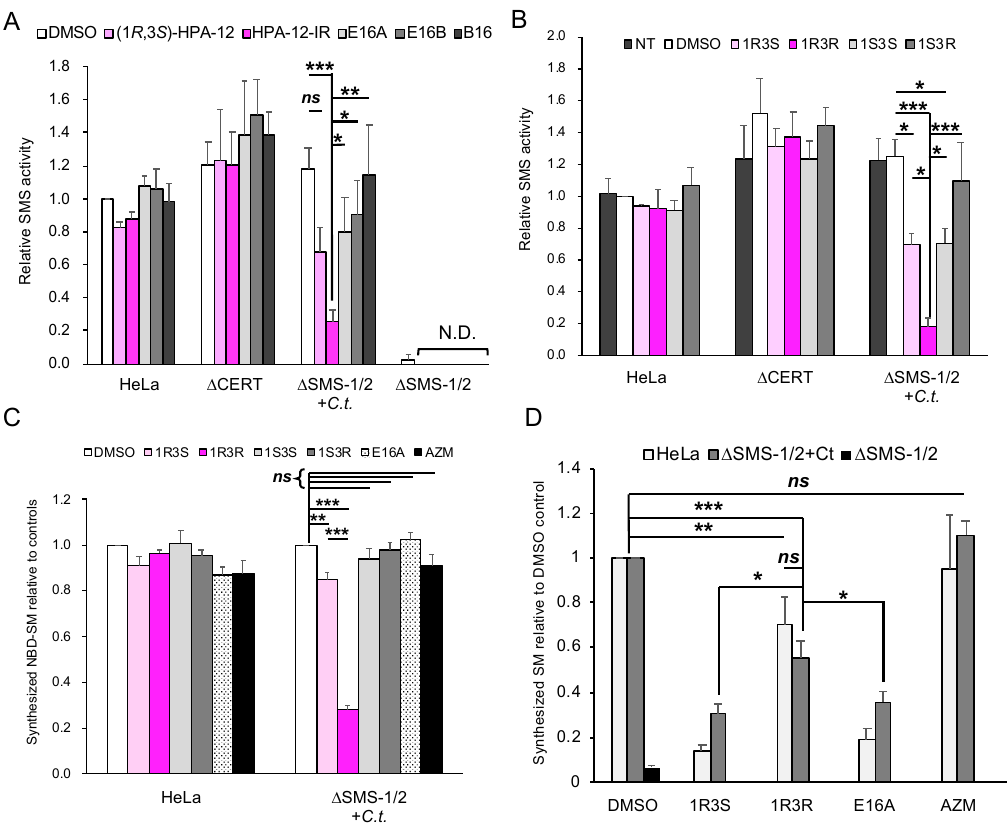
Figure 5. (1 R ,3 R )-HPA-12 is an inhibitor of cidSM-synthesis. ( A ) The effects of various compounds on the SMS activity in cell lysates. The SMS activity was determined and is shown relative to that from the DMSO-treated lysate fraction from HeLa cells. The mean values ± SD from three experiments are shown. The statistical significance between drug-treated groups in the HeLa ∆ SMS-1/2+ C.t. cells was assessed by Tukey’s test and statistically significant values are indicated (* p < 0.05; ** p < 0.01; *** p < 0.001). C.t .: C. trachomatis serovar L2-infected; N.D.: not determined. ( B ) The effects of various HPA-12 stereoisomers on SMS activity in cell lysates. The SMS activity was determined in the presence or absence of 10 µ M of each HPA-12 stereoisomer and is shown as relative to that of the DMSO-treated lysate fraction from HeLa cells. The mean values ± SD from three experiments are shown. Statistical significance between drug-treated groups in the HeLa ∆ SMS-1/2+ C.t. cells were assessed by Tukey’s test and statistically significant values are indicated (* p < 0.05; *** p < 0.001). 1R3S: (1 R ,3 S )-HPA-12; 1R3R: (1 R ,3 R )-HPA-12; 1S3S: (1 S ,3 S )-HPA-12; 1S3R: (1 S ,3 R )-HPA-12. ( C ) The effects of each compound on the metabolism of C 6 -NBD-ceramide in living cells. HeLa cells or C. trachomatis -infected HeLa ∆ SMS-1/2 cells were incubated with 1 µ M of C 6 -NBD-ceramide in the presence or absence of the indicated compound for 45 min at 37 ◦ C. Next, the lipids were extracted and separated by TLC. The levels of C 6 -NBD-SM are shown relative to the level in the DMSO-treated control. Statistical significance between drug-treated groups in the HeLa ∆ SMS-1/2+ C.t. cells were assessed by Tukey’s test and statistically significant values are indicated (** p < 0.01; *** p < 0.001; ns, not significant). AZM: azithromycin. ( D ) The effects of each compound on SM synthesis in living cells. The cells were labeled with [ 14 C]serine for 2 h at 37 ◦ C in the presence or absence of 10 µ M of the indicated compound. The lipids were extracted and separated by TLC. The relative radioactivity of the synthesized SM in the compound-treated cells normalized to the DMSO control cells are shown, except that the DMSO-treated HeLa ∆ SMS-1/2 cells was normalized to the DMSO-treated HeLa cells. Statistical significance between the selected groups (HeLa cells treated with DMSO or (1 R ,3 R )-HPA-12, and chlamydia-infected HeLa ∆ SMS-1/2 cells treated with (1 R ,3 S )-HPA-12, (1 R ,3 R )-HPA-12, E16A, and azithromycin) was assessed by Tukey’s test and statistically significant values are indicated (* p < 0.05; ** p < 0.01; *** p < 0.001; ns, not